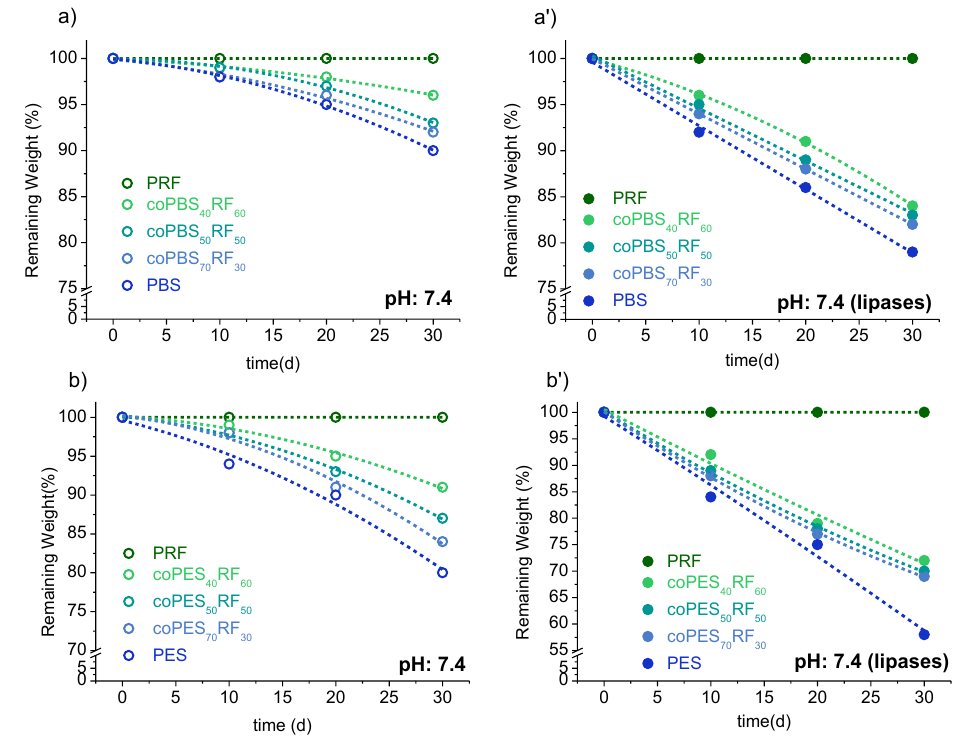
Figure 11. Weight loss of resorcinol-containing succinate-furanoatecopolyesters as a function of incubation time in aqueous buffer at pH 4 and 37 °C ( a , b ) and under the same conditions but with lipases added to the incubation medium ( a’ , b’ ).